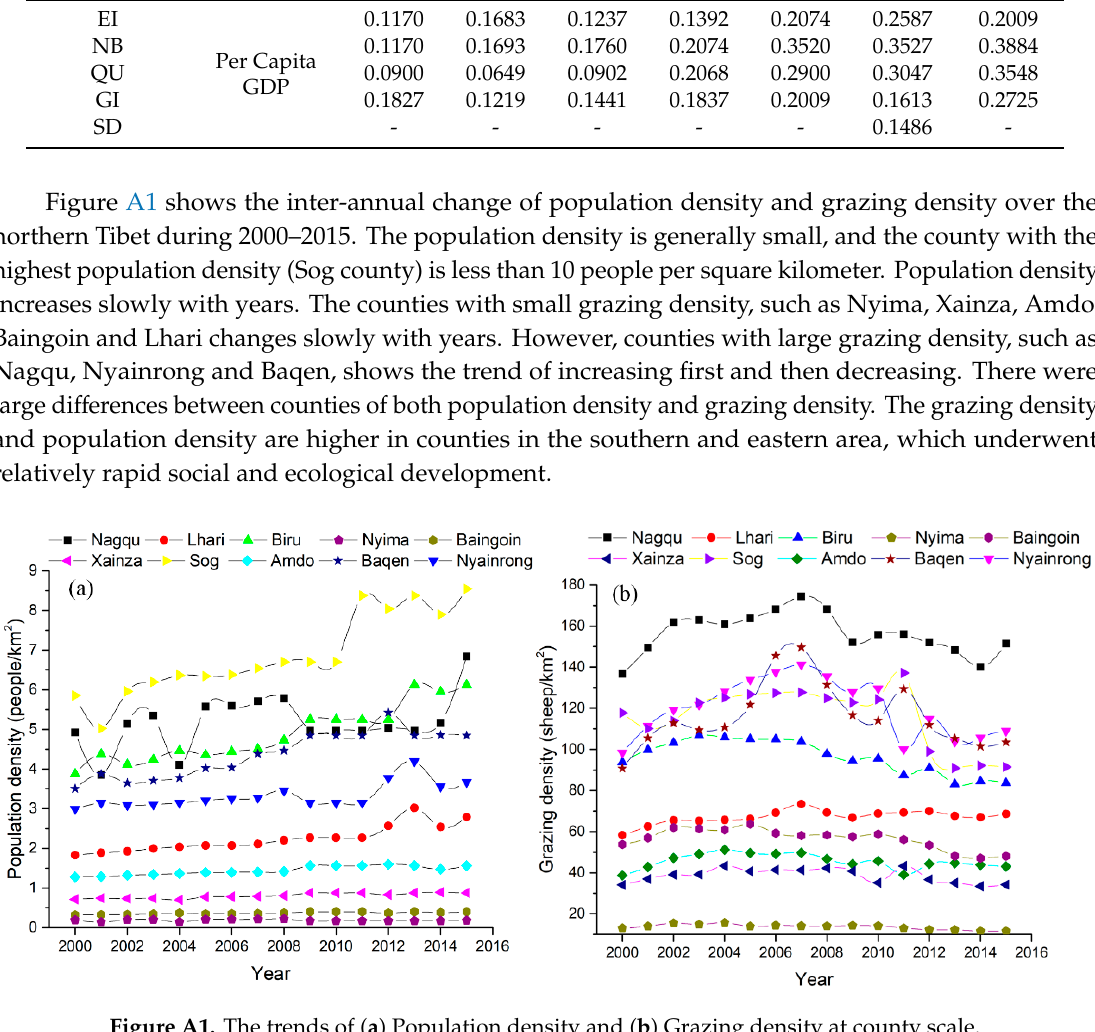
Figure A1. The trends of ( a ) Population density and ( b ) Grazing density at county scale.